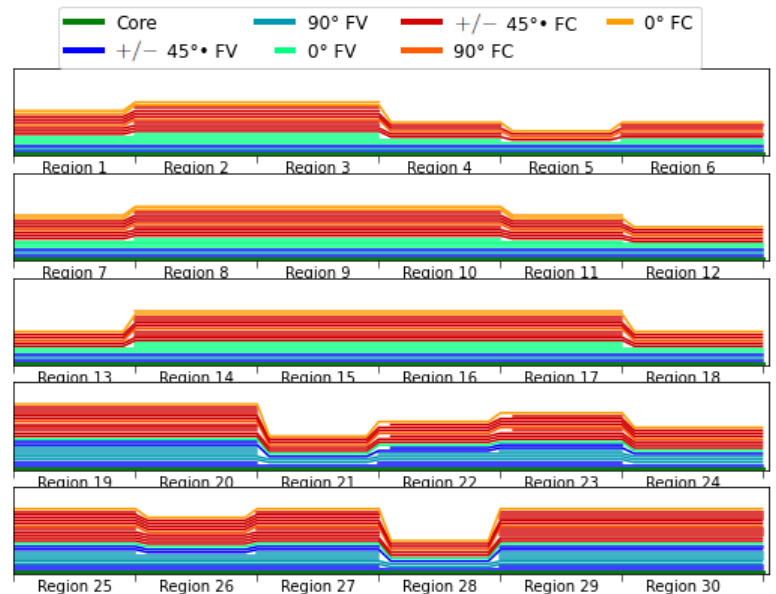
Figure 18. Schematic representation of the laminate selected through MCDM from the MOSOP3 PF.